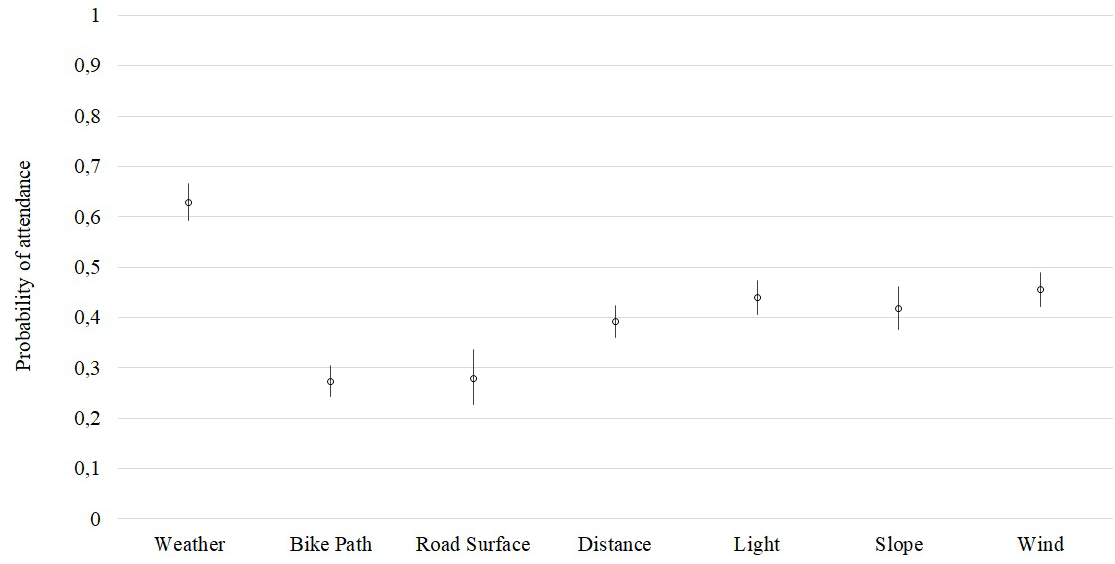
Figure 12. The estimated probability of attendance and the 95% confidence interval per situation